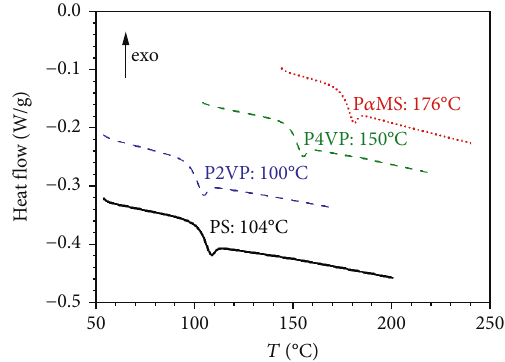
Figure 6: Results of di ff erential scanning calorimetry measurements at ambient pressure. The curves are shifted vertically for